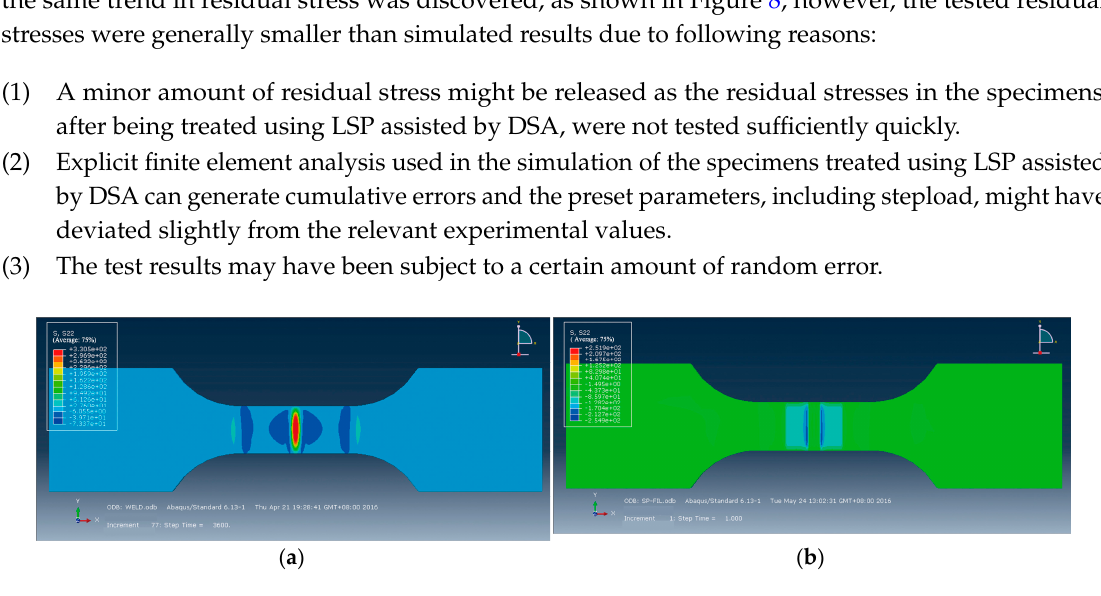
Figure 9. Simulation of surface residual stresses distribution: ( a ) untreated; ( b ) LSP at 130 °C.